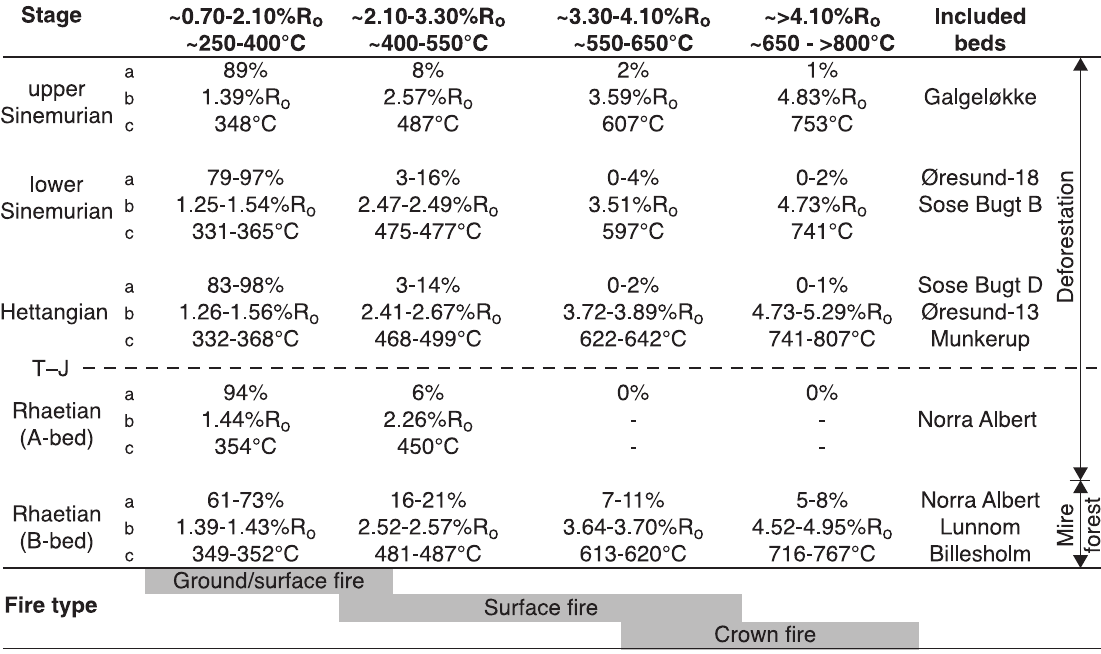
Figure 5. Inertinite reflectance populations and assumed burning temperatures. High-reflecting inertinite corresponding to temperatures . 600 u C that can be obtained in crown fires of stands of conifers is particular abundant in the Rhaetian